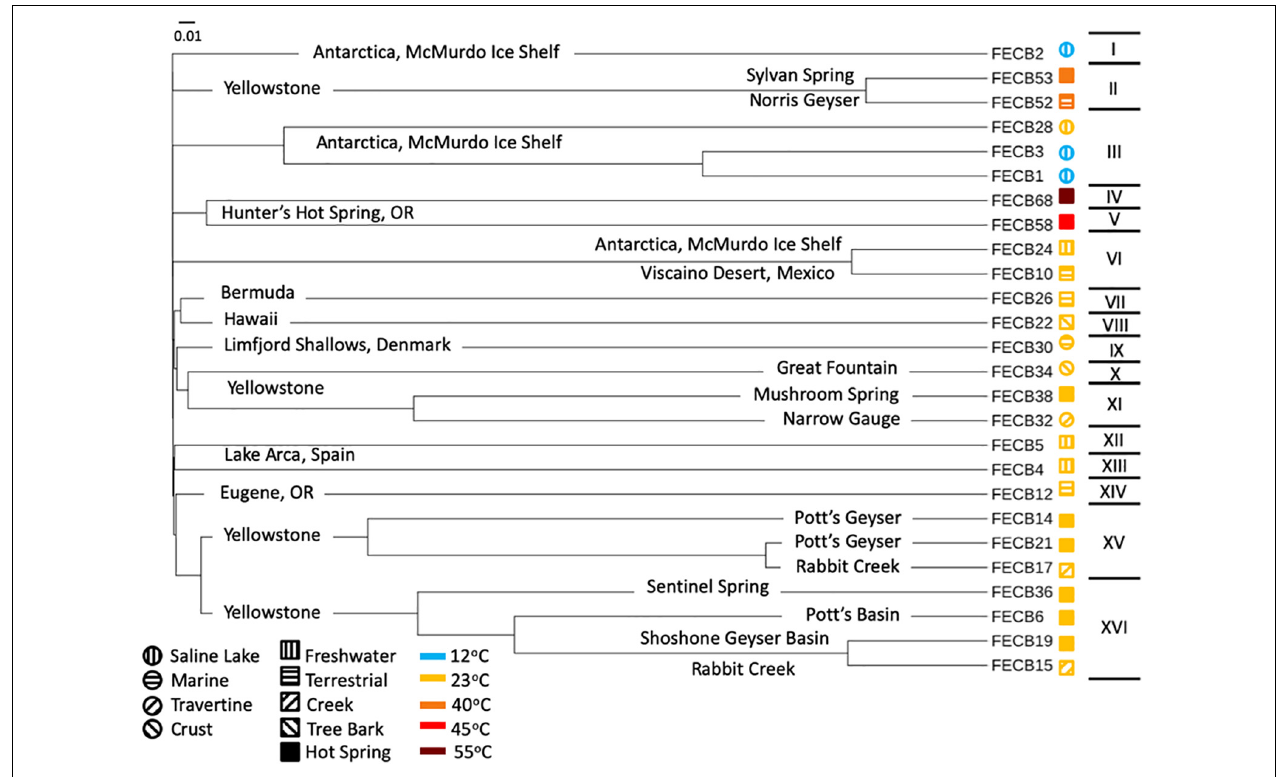
FIGURE 1 | Cladogram of 16S rRNA based community composition of co-cultures under investigation. FECB identifier (sample ID) is provided for each co-culture. Sample location is indicated on the corresponding branch. Roman numerals on the right indicate the clusters identified at a branch cutoff of 0.05. Symbols (i.e., circles and squares) next to sample ID indicate habitat type and color indicates the temperatures at which sample was historically maintained in the CCMEE. Branch length indicates (number of differences/overall length of branches) between two